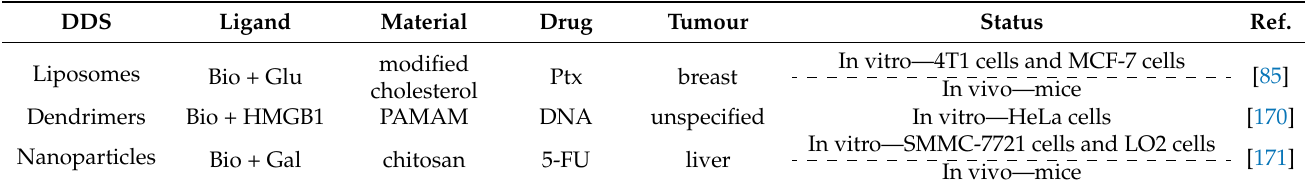
Table 6. The examples of dual-targeted nanoparticles with biotin.